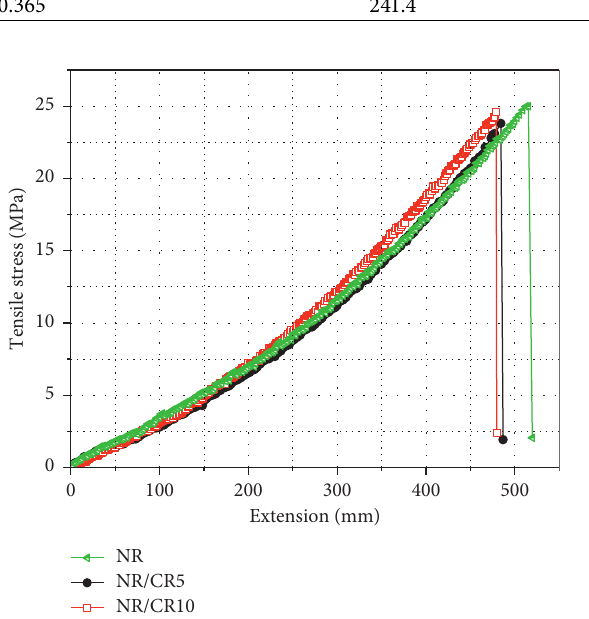
Figure 2: Stress–strain curves of NR and NR/CR blends. Table 3: Mechanical properties of NR and NR/CR